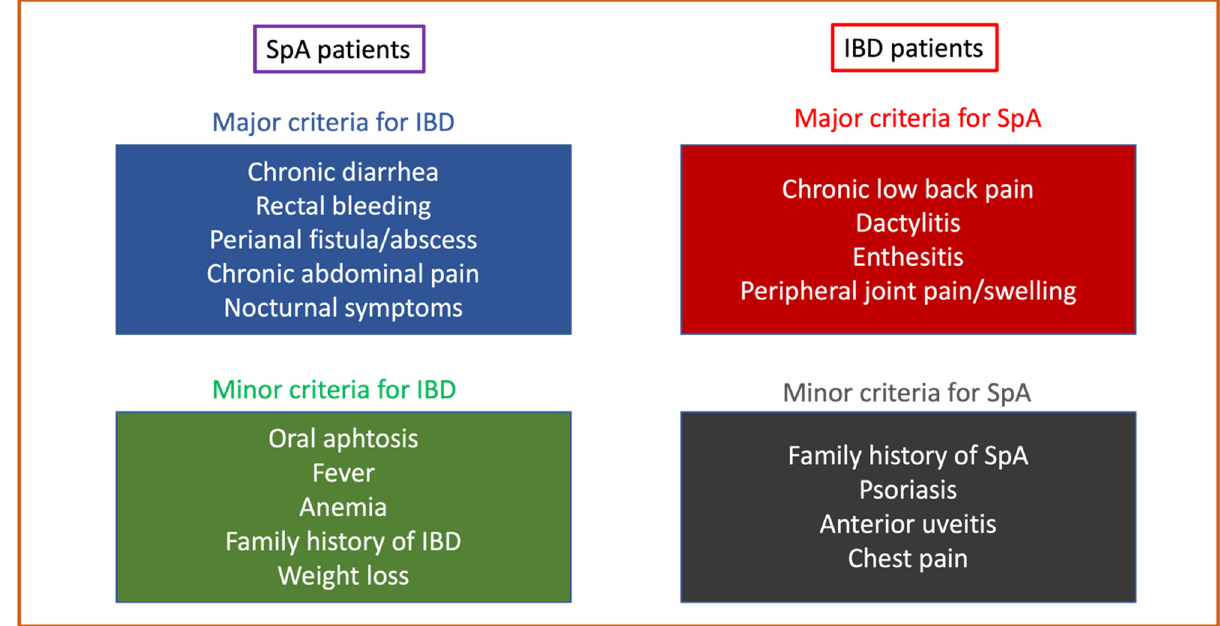
Figure 1. Red flags proposed for referral between gastroenterogists and rheumatologists for early diagnosis of coexisting inflammatory bowel disease (IBD) and spondyloarthritis (SpA) [6].